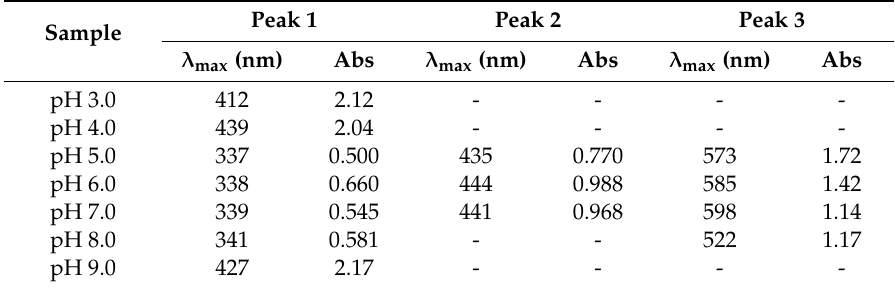
Table 2. UV-Vis results of triangular Ag nanoplates synthesized by a mixture of gelatin (0.2%, w / v )-chitosan (0.06%, w / v ) at di ff erent pH values.